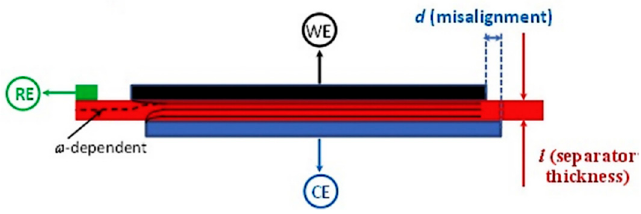
Figure 13. Example of misalignment, d, between the positions of WE and CE. When d is comparable with the separator thickness, l, this results in a frequency ( ω )-dependent change in the position of the equipotential surface probed by the RE. Reproduced with permission from [78].